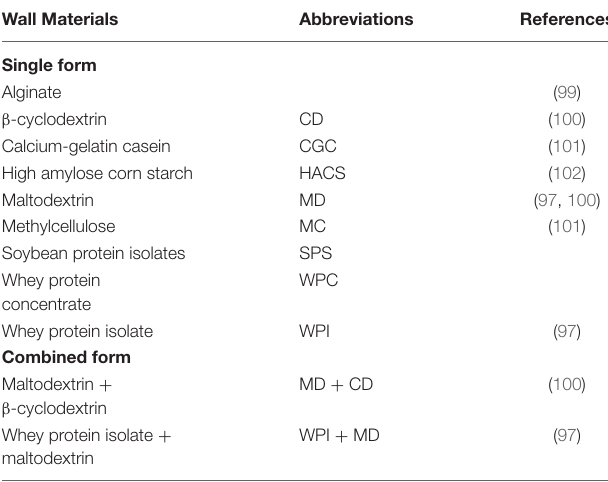
TABLE 2 | Wall materials for functional ingredients